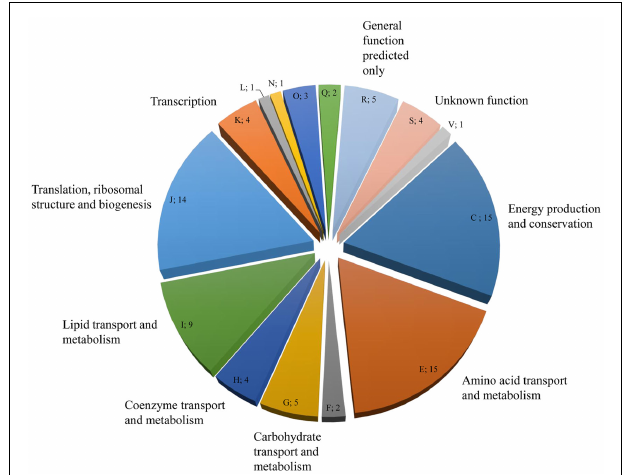
FIGURE 4 | Distribution and number of S. acidocaldarius biofilm EPS proteins in the different arCOGs functional categories . For identification, EPS isolated from unsaturated S. acidocaldarius biofilms (4days, 78°C) was digested with trypsin and applied for nanoRSLC-Orbitrap LC-MS/MS analysis. Proteins were assigned to arCOG functional categories (capital letters). F, Nucleotide transport and metabolism, L: